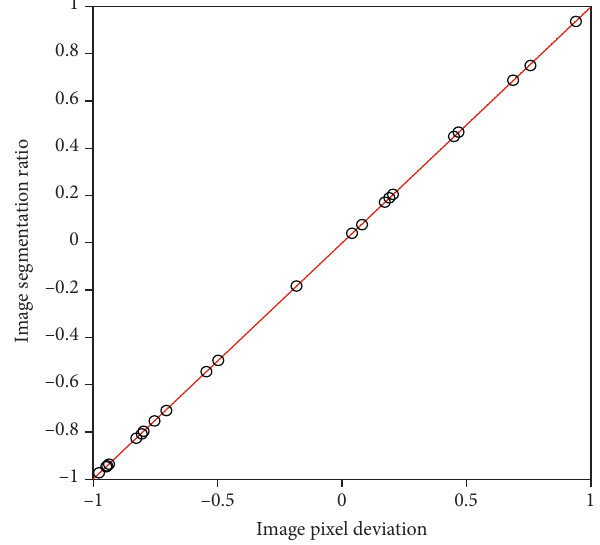
Figure 10: Linear fi tting of the image superpixel segmentation ratio based on partial di ff erential equations.